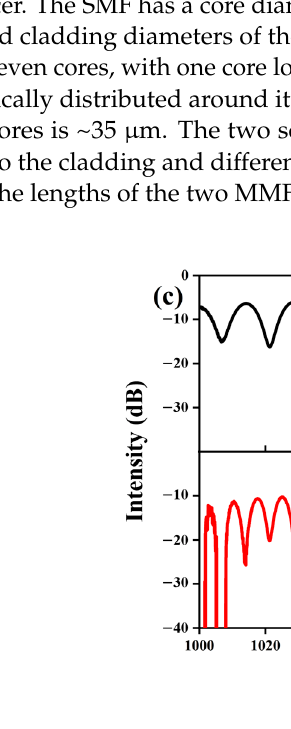
Figure 1. ( a ) Schematic diagram of the filter structure. ( b ) Experimental setup to measure the characteristics of the interference filter. ( c ) Transmissivity curves.